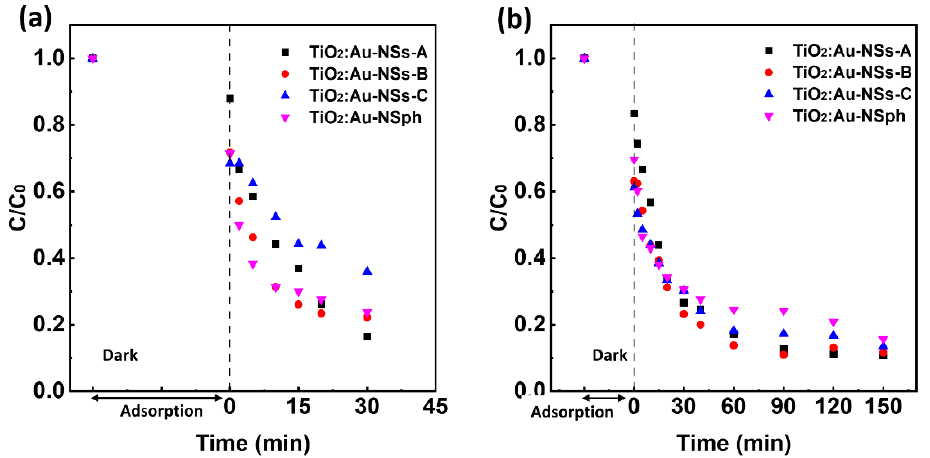
Figure 4. Photocatalytic degradation of CIP (5 mg/L) with TiO 2 :Au-NSph, TiO 2 :Au-NSs-A, B, and C nanoparticles under 30 min of UV radiation ( a ) and 150 min of visible radiation ( b ).